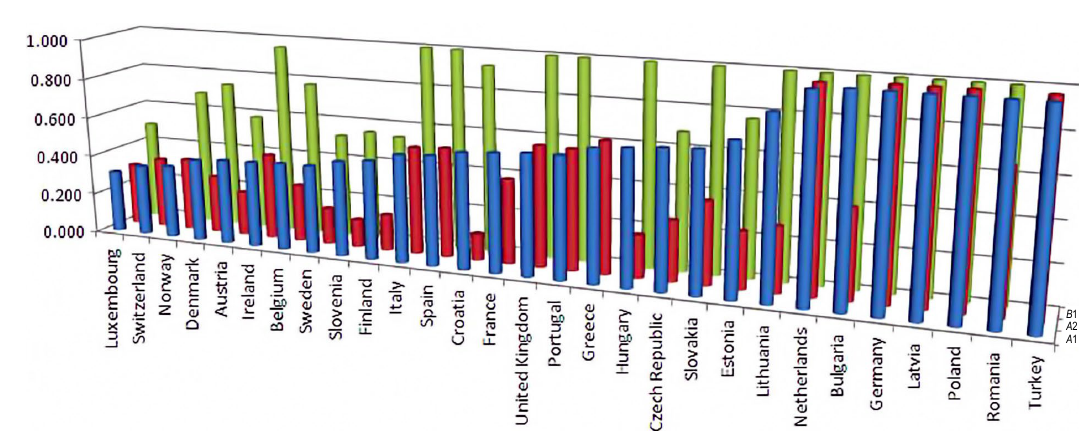
Fig. 1. Ranking with the original DEA method (Markovits-Somogyi 2011a)